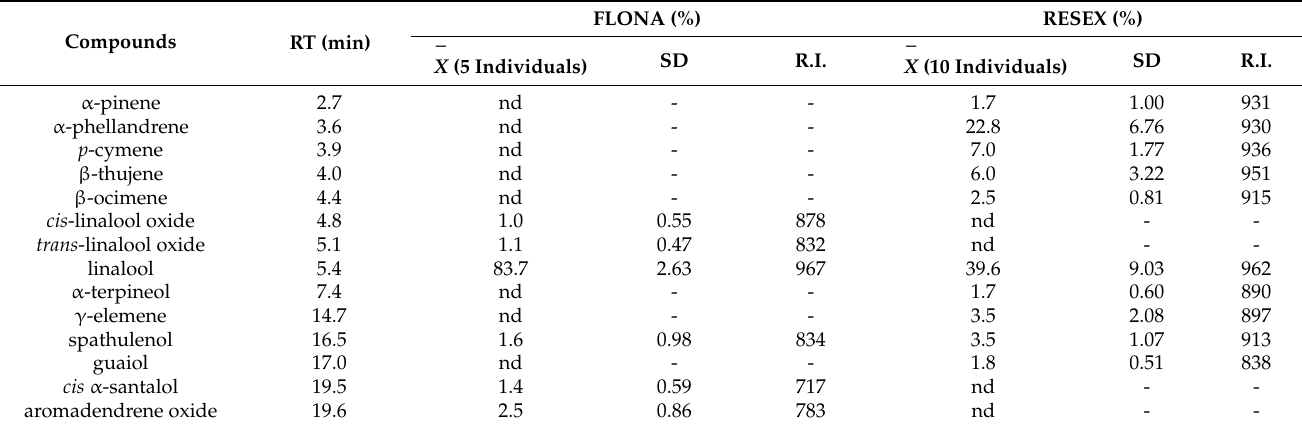
Table 1. Volatiles (%) identified in essential oils from rosewoods from FLONA and RESEX.